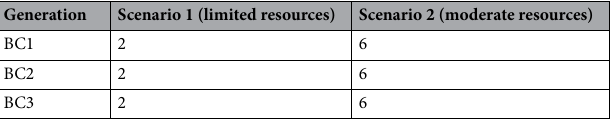
Table 2. Numbers of crosses in each generation for two different scenarios.